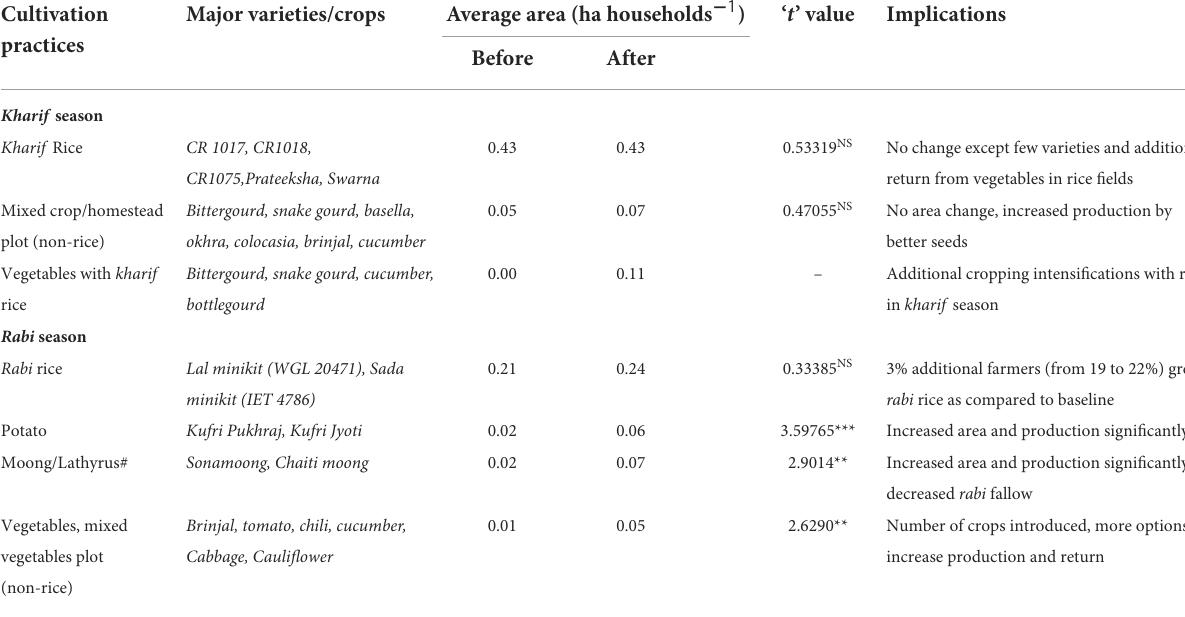
TABLE 3 Cultivation practices before and after the project